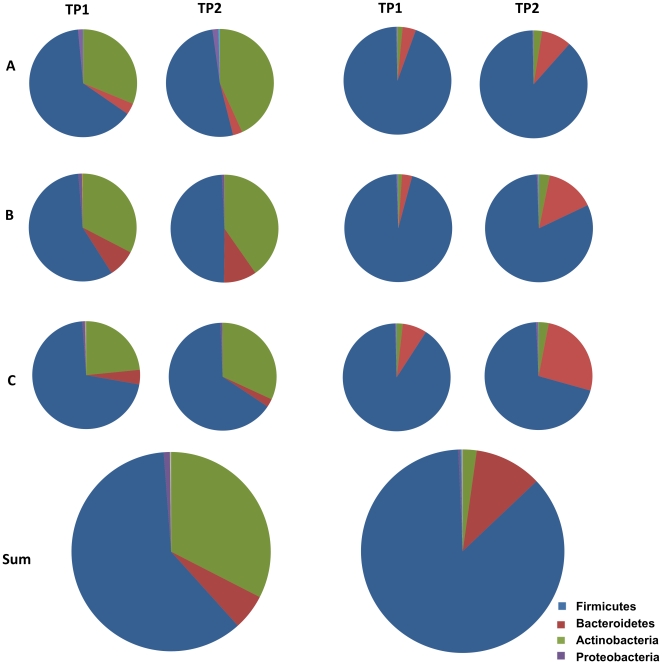
Phylogenetic classification based on metaproteome and phylogenetic analysis.The major phyla per subject (A, B, and C) and time point (TP1 and TP2) based on metaproteome (left) and phylogenetic (right) analysis summed and averaged over all analysed samples are presented.